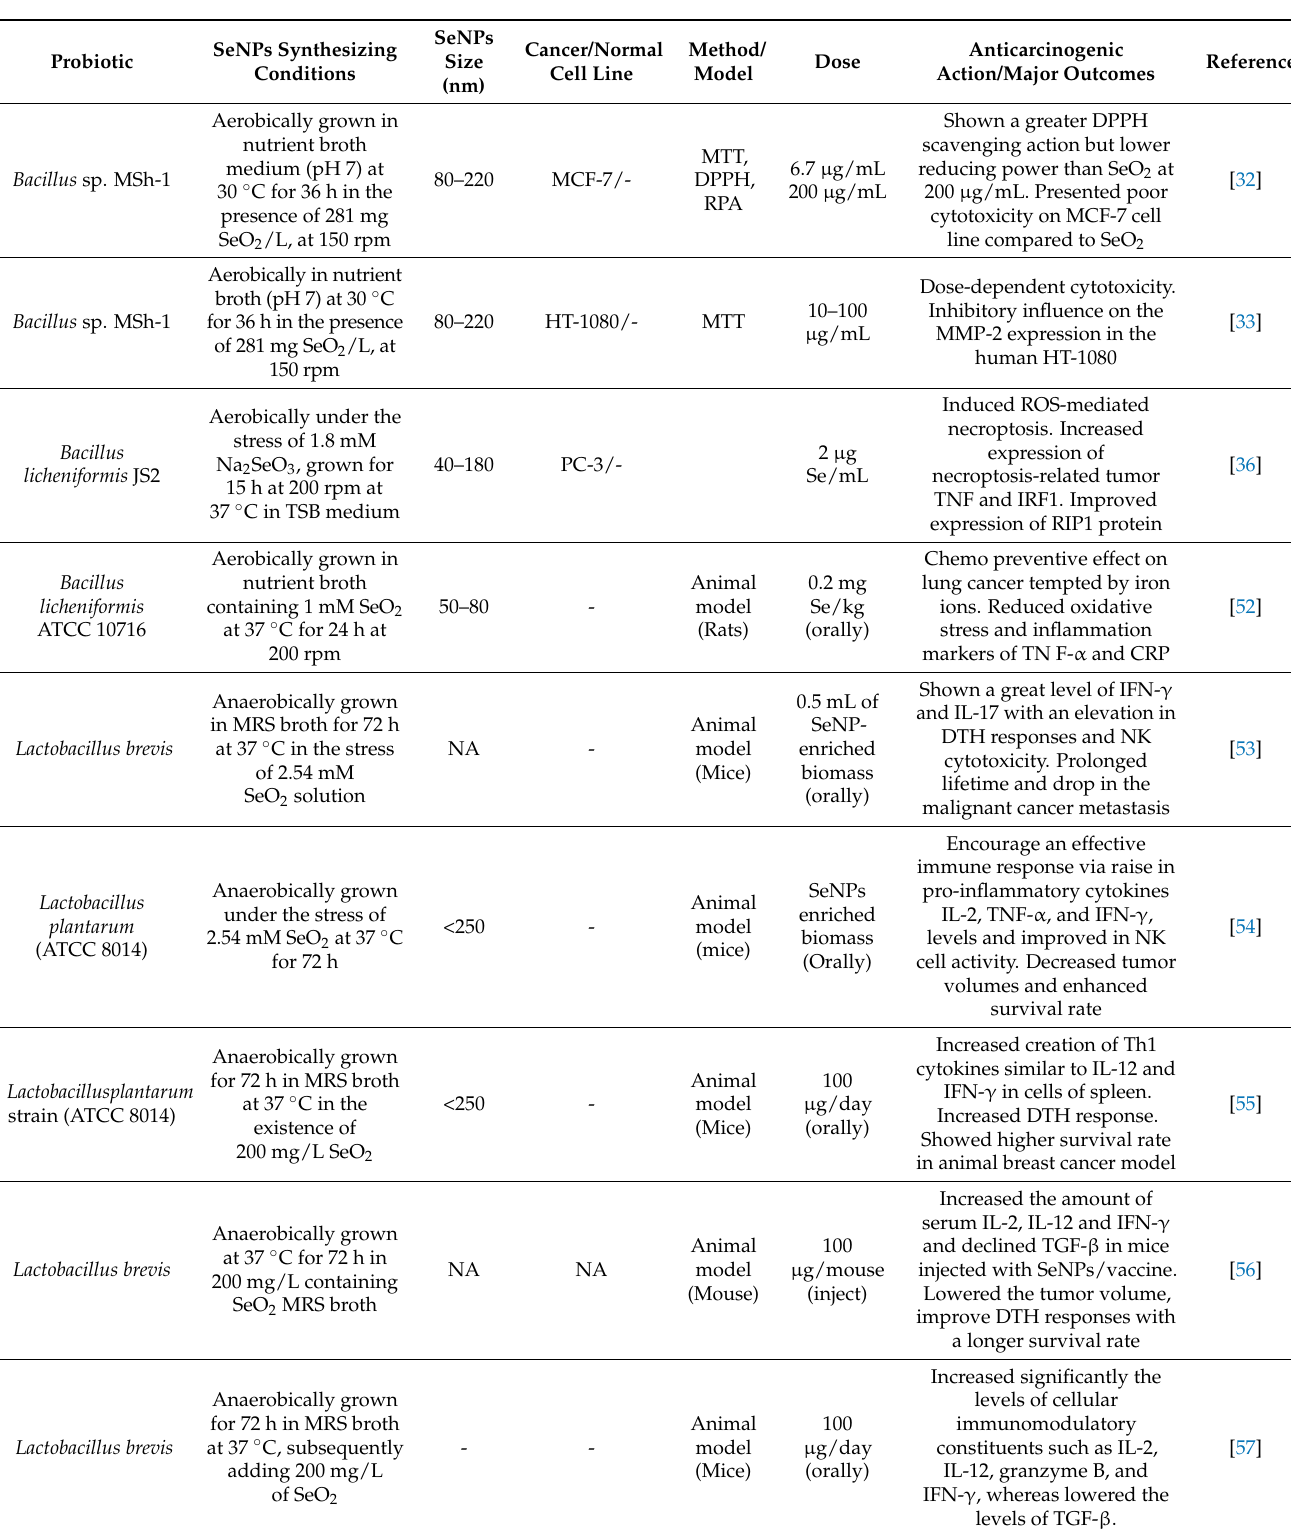
Table 1. Summary of current work on SeNPs produced by probiotic/nonpathogenic bacteria with potential anticancer